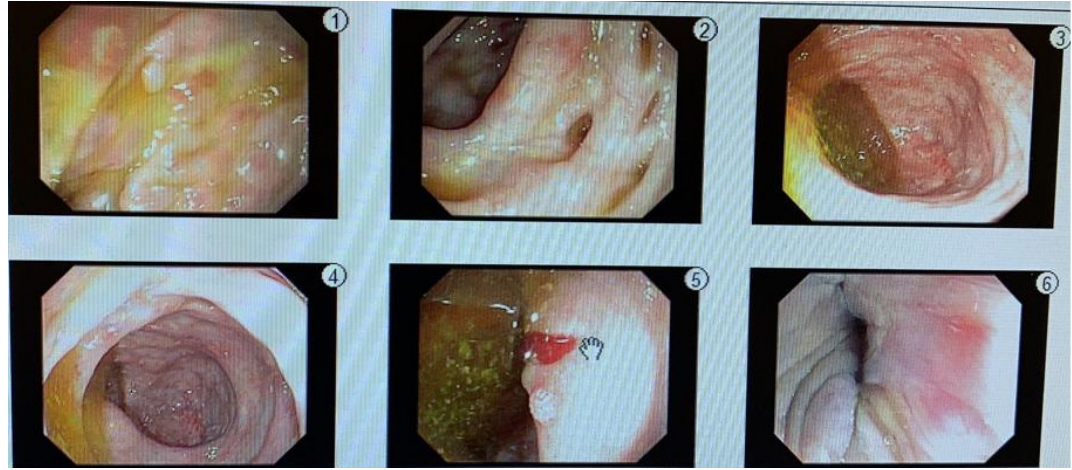
Figure 1. Colonoscopy images showing diffuse mucosa erosions.